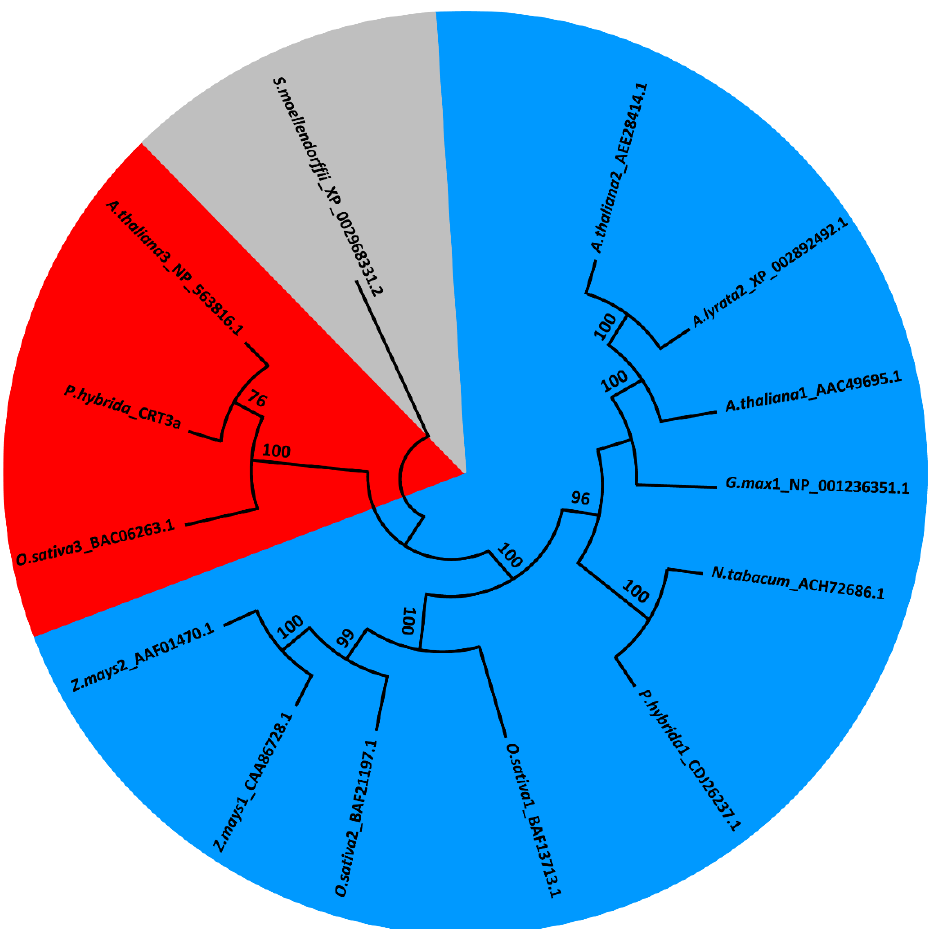
Figure 4. Phylogenetic analysis of selected plant CRT amino acid sequences. The analysis includes the newly identified Ph CRT3a and 12 isoform-verified CRTs obtained from NCBI with the following accession numbers: Arabidopsis thaliana (AAC49695.1; AEE28414.1; NP_563816.1), Arabidopsis lyrata (XP_002892492.1), Nicotiana tabacum (ACH72686.1), Glycine max (NP_001236351.1), Oryza sativa (BAF13713.1; BAF21197.1; BAC06263.1), Petunia hybrida (CDJ26237.1), and Zea mays (CAA86728.1;